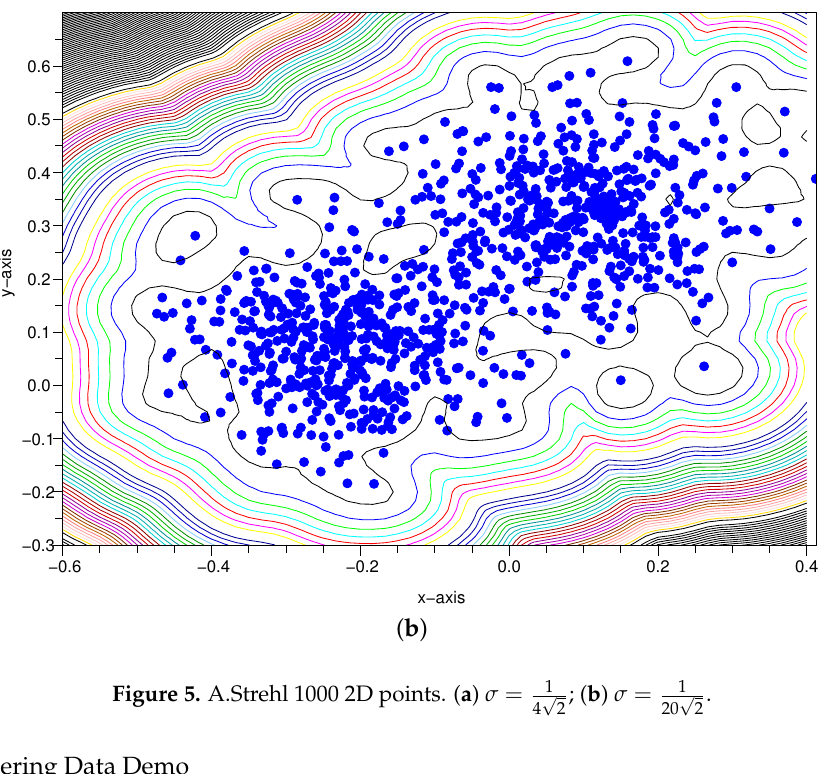
Figure 5. A.Strehl 1000 2D points. ( a ) σ = 1